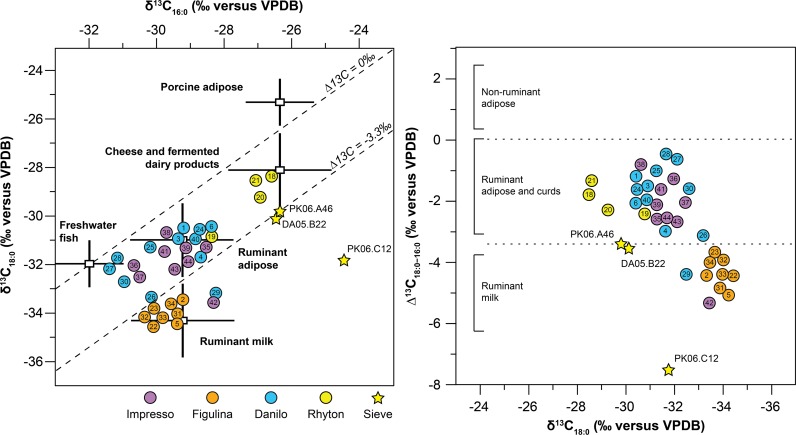
Stable carbon isotope compositions of individual fatty acids in lipid residues of animal origin from Neolithic potsherds from Pokrovnik and Danilo Bitinj, Dalmatian coast, Croatia.Animal origins are indicated based on previous studies by Evershed and colleagues [32,33,36,51]. (See S2 Table for list of pottery samples and biomarker data).